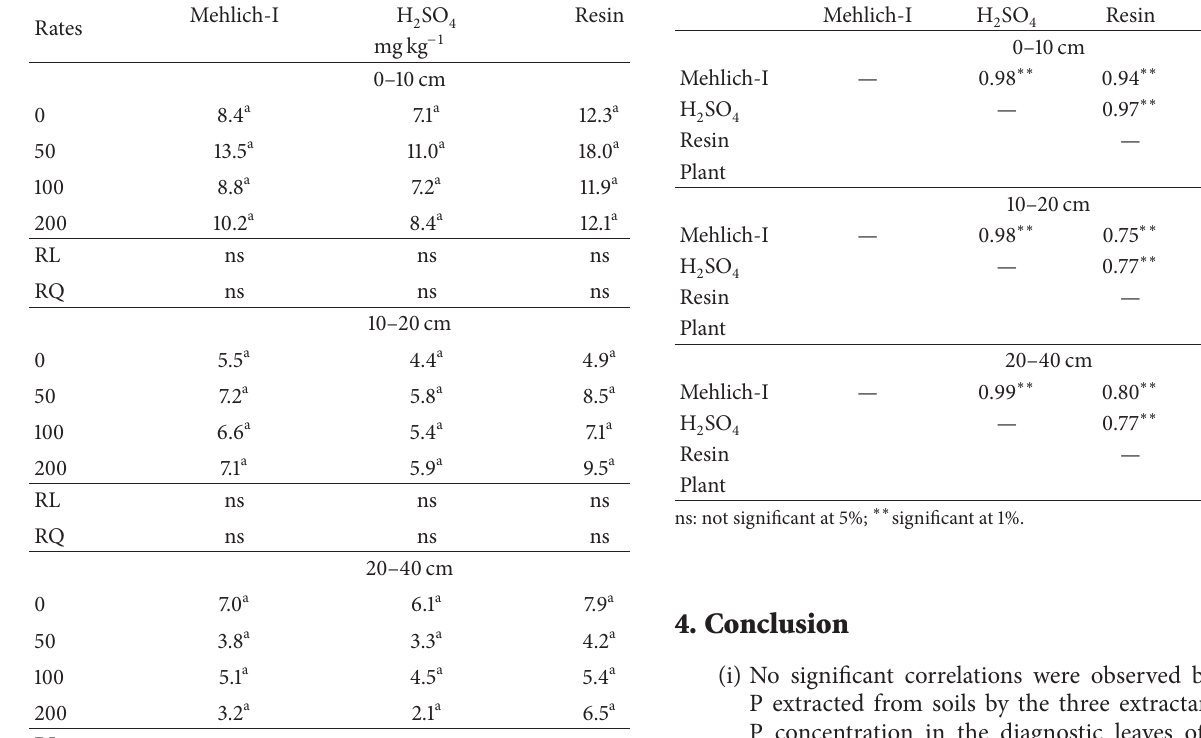
Table 5: Mean of phosphorus concentrations extracted by Mehlich- SO , and resin from samples collected at three depths from soils I, H 2 4 treated with varying rates of sewage sludge and composted sewage sludge, in the short-term experiment ( 𝑛 = 4 ).